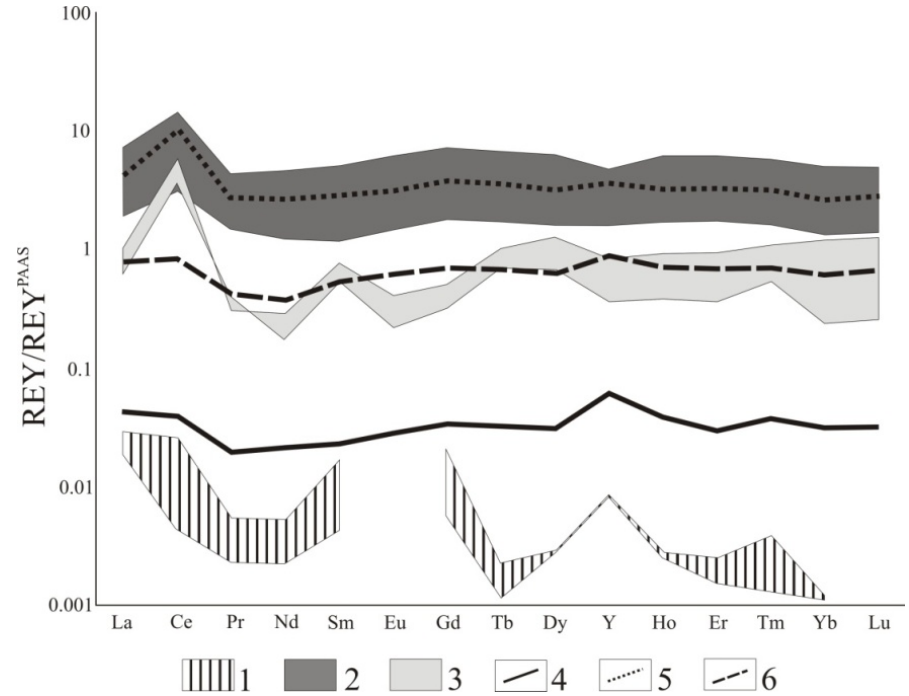
Figure 9. Shale-normalized (PAAS [47]) REY patterns of Fe-Mn deposits of differing genesis in fraction II: 1—hydrothermal Fe-Mn deposits from the Sea of Japan, [7]; 2—combined data on hydrogenetic Fe-Mn crusts from the North Pacific, [48] and the Central Pacific (our unpublished data); 3—phosphatized Fe-Mn crusts from the Central Pacific (our unpublished data); 4—diagenetic ring-like Fe-Mn nodule from the Sea of Okhotsk, [52]; 5—sample 431-5; 6—sample 431A-12.